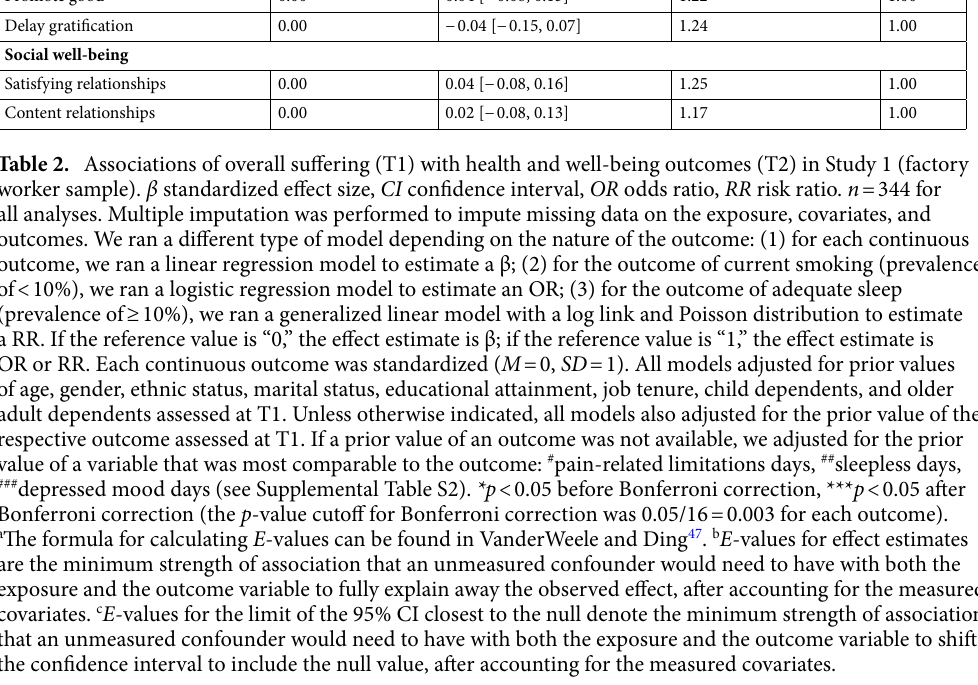
We used E -values to assess the robustness of the results from the primary analysis to potential unmeasured confounding 47 . E -values estimate the minimum strength of association that an unmeasured confounder would need to have with both the exposure and outcome (on the risk ratio scale), above and beyond adjusted covariates, to fully explain away the observed exposure-outcome association. E -values can range from 1.00 to any number greater than 1.00; higher values indicate that stronger unmeasured confounder risk ratio associations would be needed to explain away the association between the exposure and outcome. For the associations that were for pain ‑ related limitations (effect estimate: 1.69, confidence interval limit: 1.39) and depressed mood (effect estimate: 1.58, confidence interval limit: 1.26) were somewhat robust to potential unmeasured confounding. Secondary analysis: associations of suffering aspects with health and well‑being outcomes. We repeated the pri- mary analysis after replacing overall suffering with each aspect of suffering as the exposure variable (one aspect of suffering and one outcome at a time). All seven aspects of suffering were modeled as continuous variables. The results for this set of analyses can be found in Supplemental Table S8. Consistent with the results of the primary